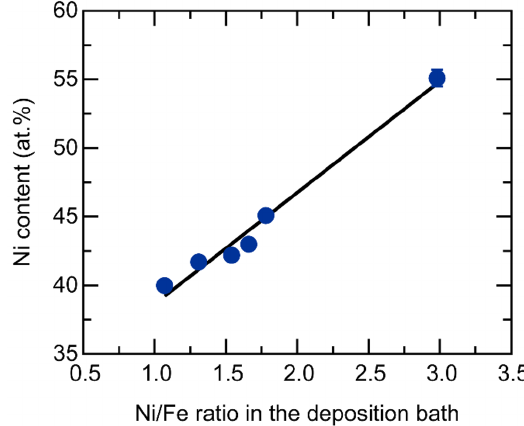
Figure 1. Effect of the Ni/Fe ratio of the deposition bath on the Ni content of electrodeposited Fe-Ni